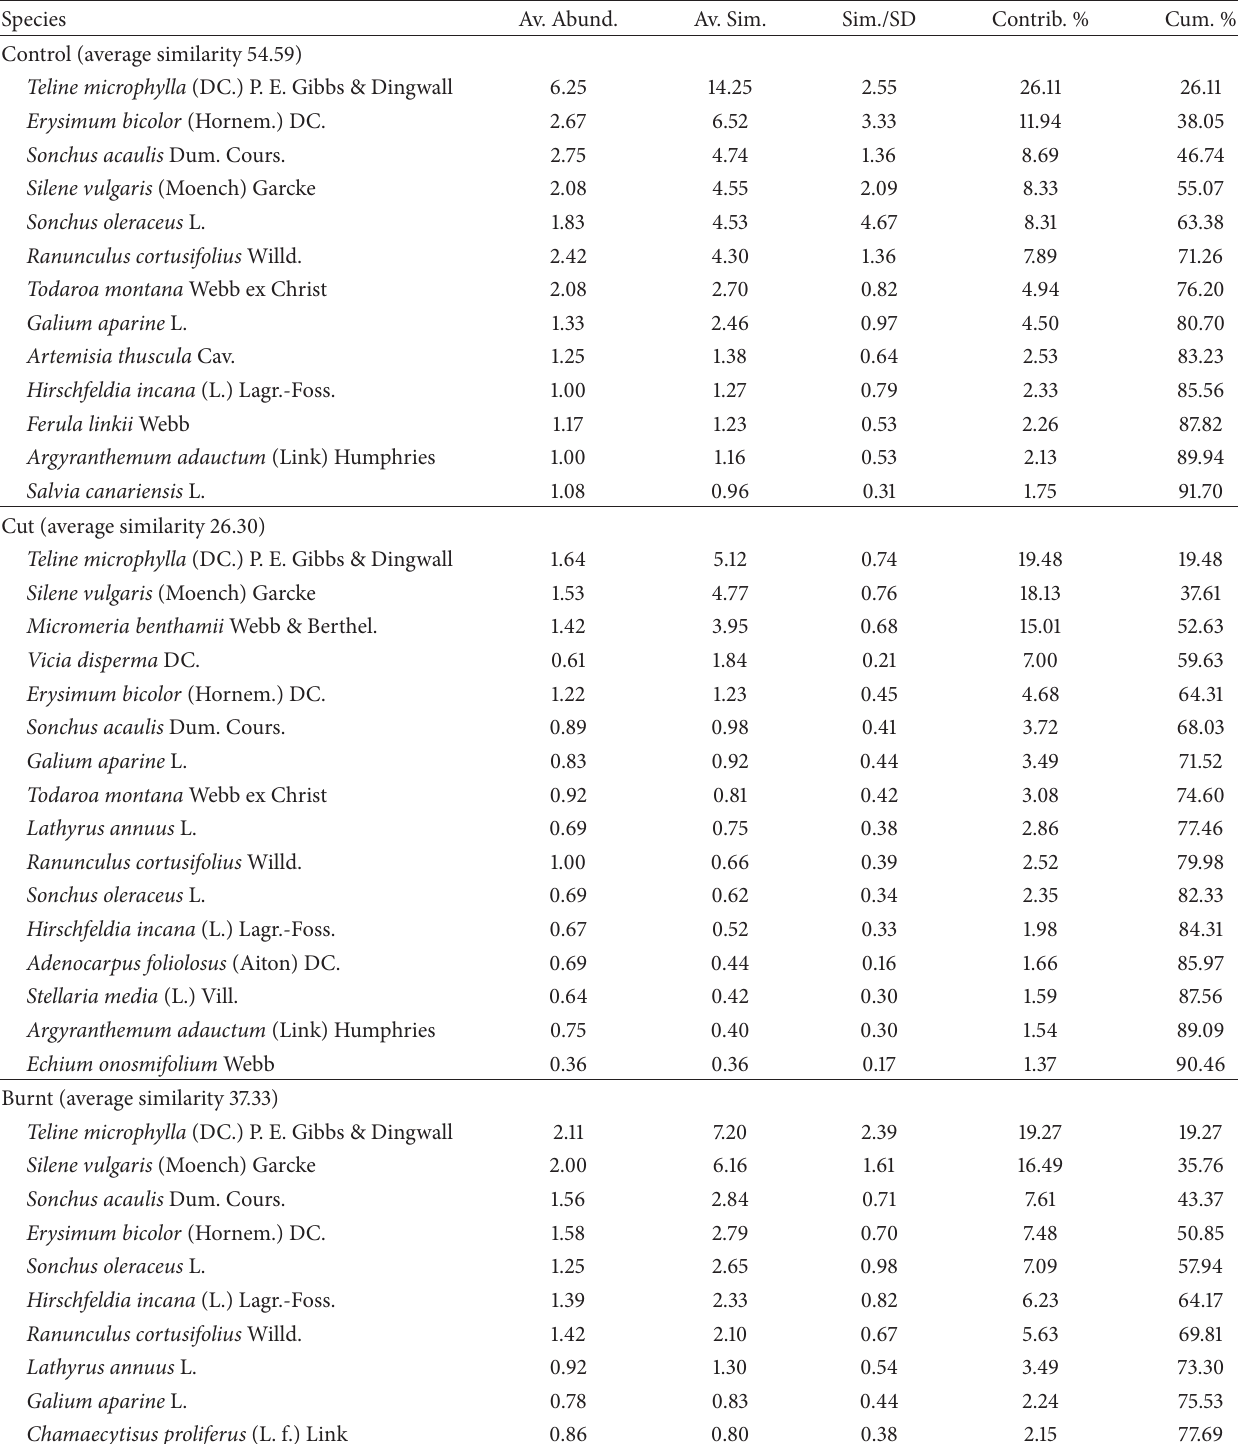
Table 2: Cutting and burning effects on species composition in Pinus canariensis forest stand (Gran Canaria, Canary Islands). Results of the SIMPER procedure conducted to identify descriptor species associated with each treatment. The taxa which contribute to the similarity within treatment, using a cut-off cumulative percentage of 90%, are listed. Av. Abund.: average abundance of taxa based on a scale of 1 to 9